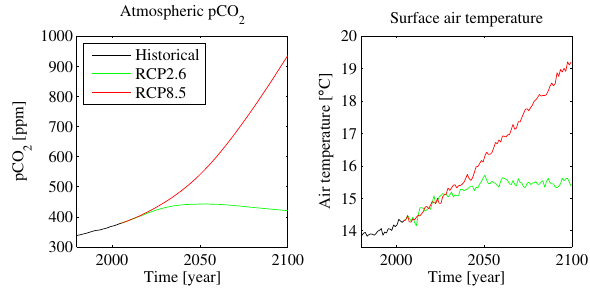
Fig. 2. The left panel shows atmospheric p CO 2 concentrations for the historical period (black; 1860–2005), RCP 2.6 (green; 2005– 2100) and RCP 8.5 (red; 2005–2100). The right panel shows global average surface air temperature simulated for the same